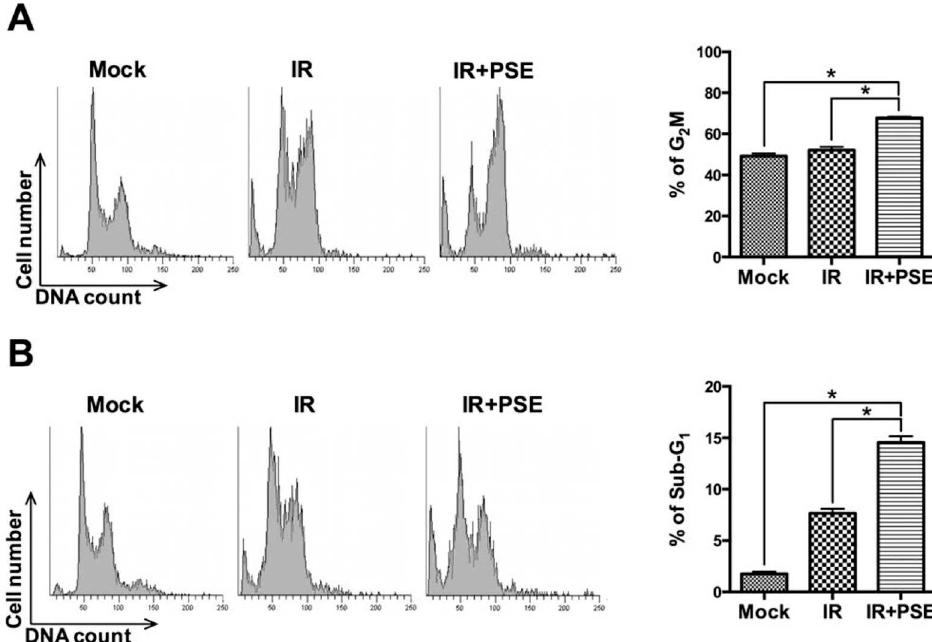
Fig 4. Peanut stem extract (PSE) induces cell cycle arrestfollowed by apoptosis of radioresistant prostate cancer cells. LAPC4-KDcells were untreated(mock) or exposedto IR (2Gy) alone or combinedwith PSE (500 μ g/mL) and incubatedfor (A) 24 and (B) 48 h. Cell cycle distributionbasedon DNA content was analyzedusing flow cytometry. Percentagesof cells in G2/M and sub-G1 phases were calculatedand plotted as intensity bars in right